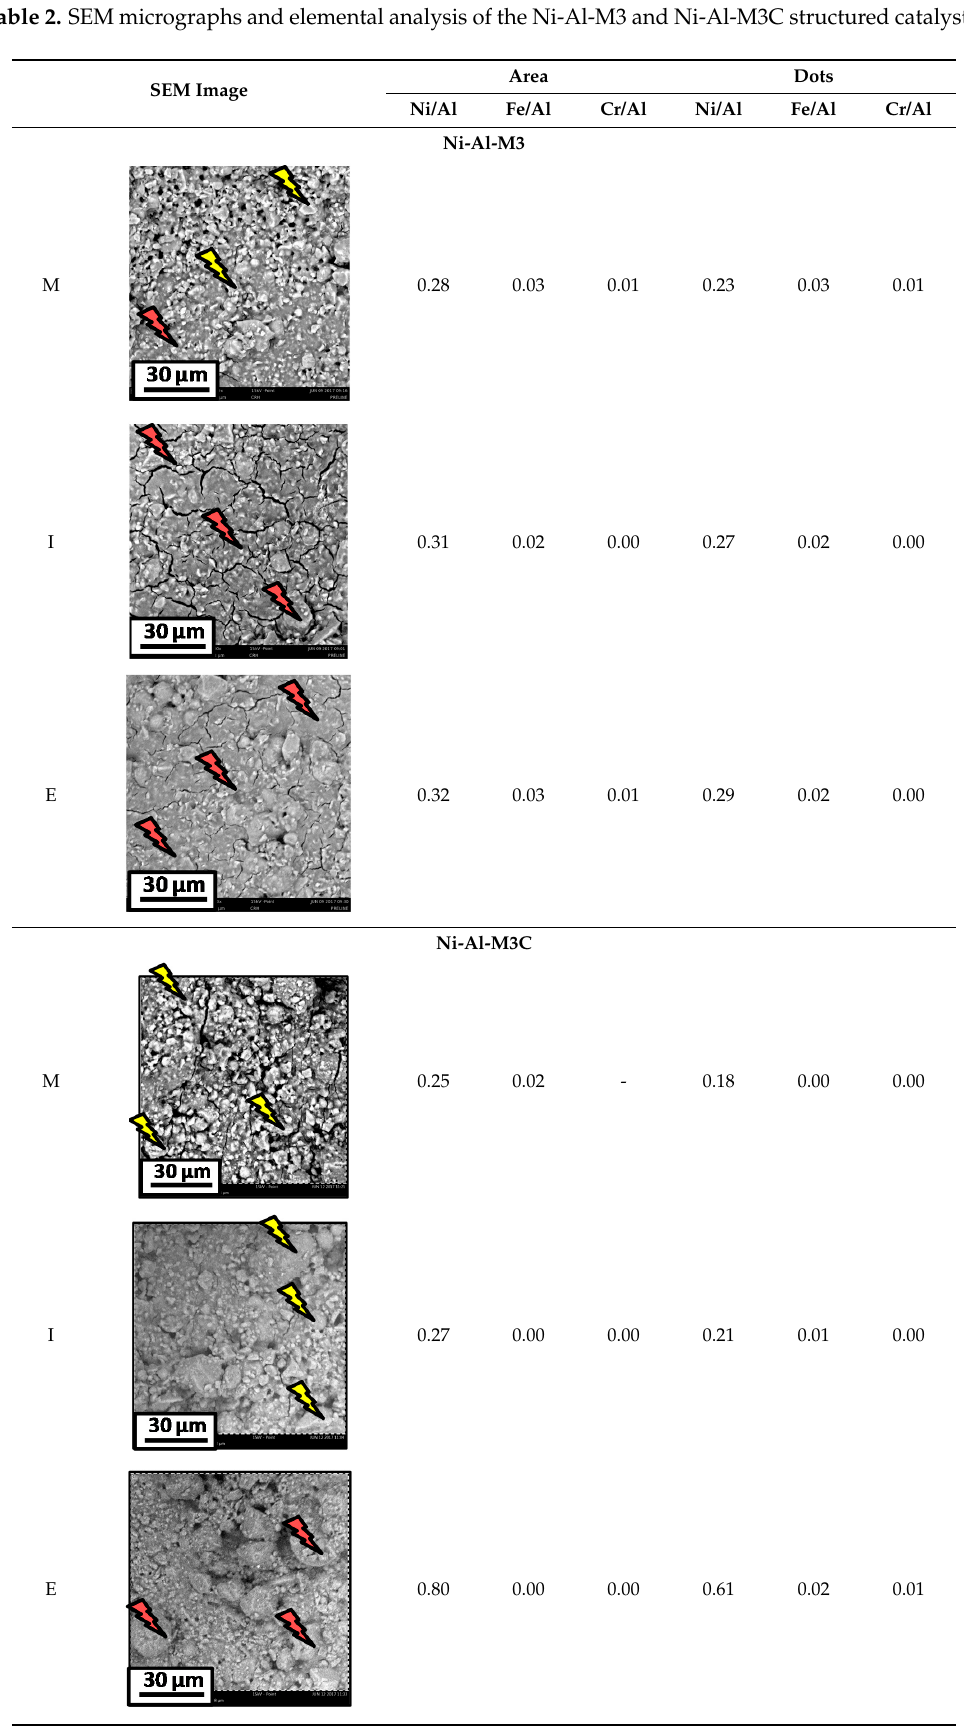
Table 2. SEM micrographs and elemental analysis of the Ni-Al-M3 and Ni-Al-M3C structured